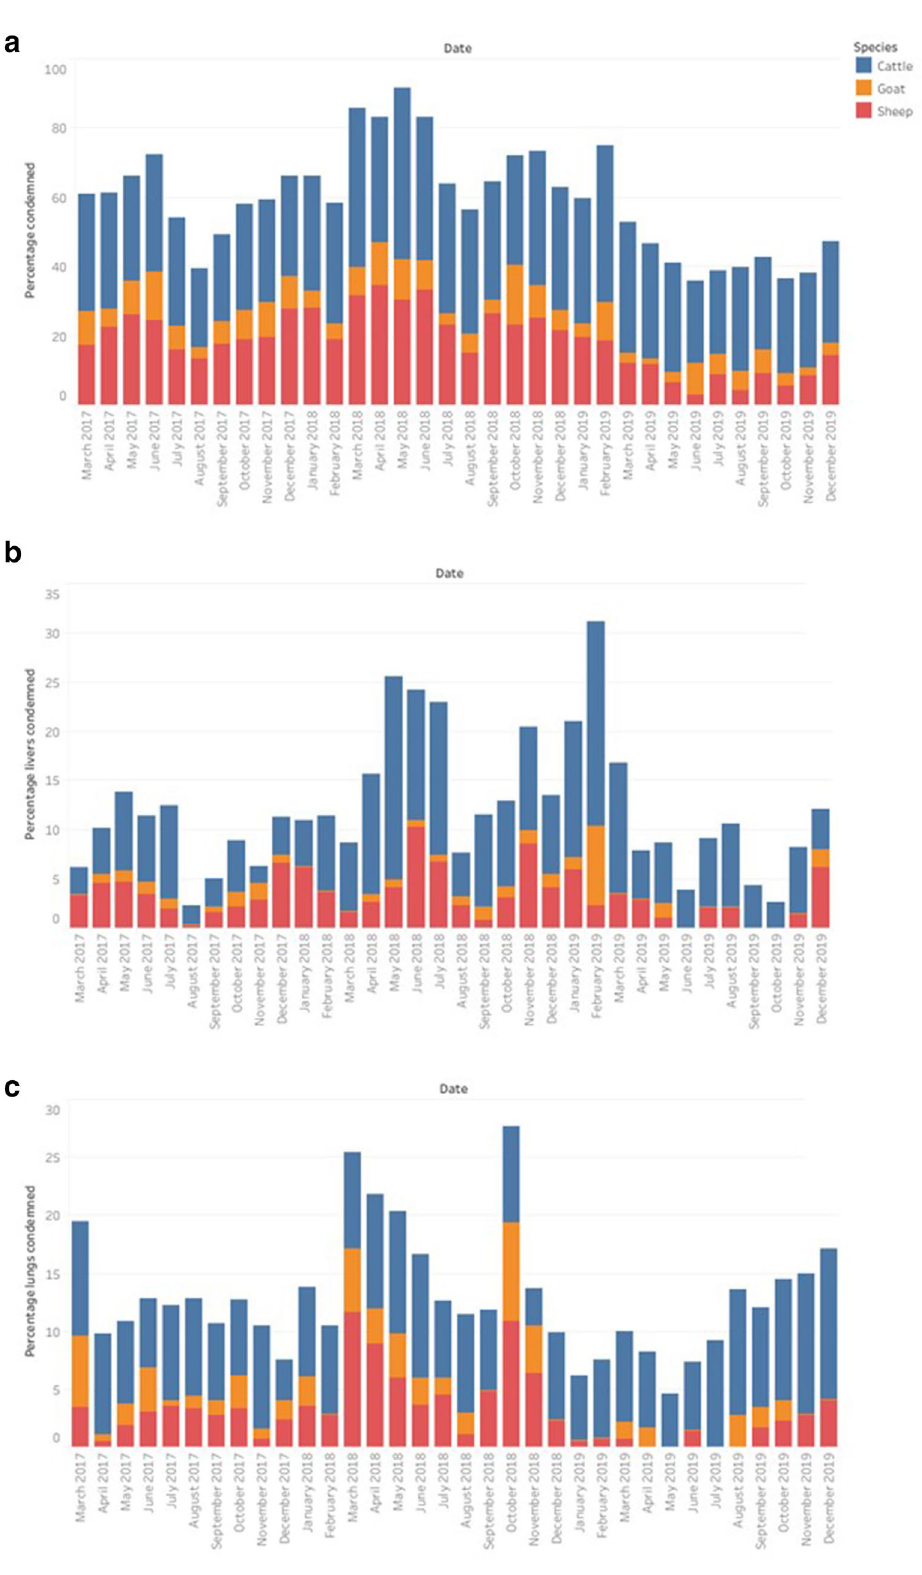
Figure 6. The percentage of condemnations (a) , and the percentage of livers (b) and lungs (c) condemned in two slaughterhouses in Bungoma County, western Kenya, between 17th March 2017 and 31st December